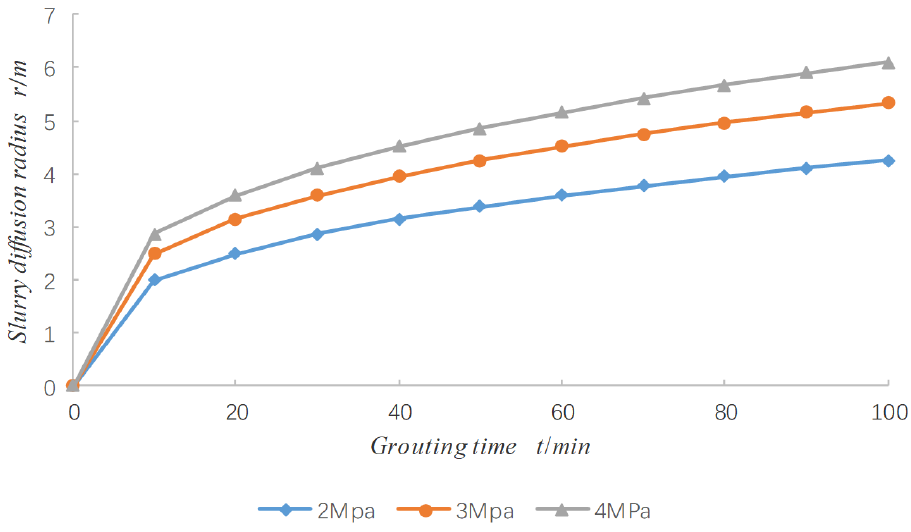
Figure 7. Variation in diffusion radius r with time under varying grouting pressures.